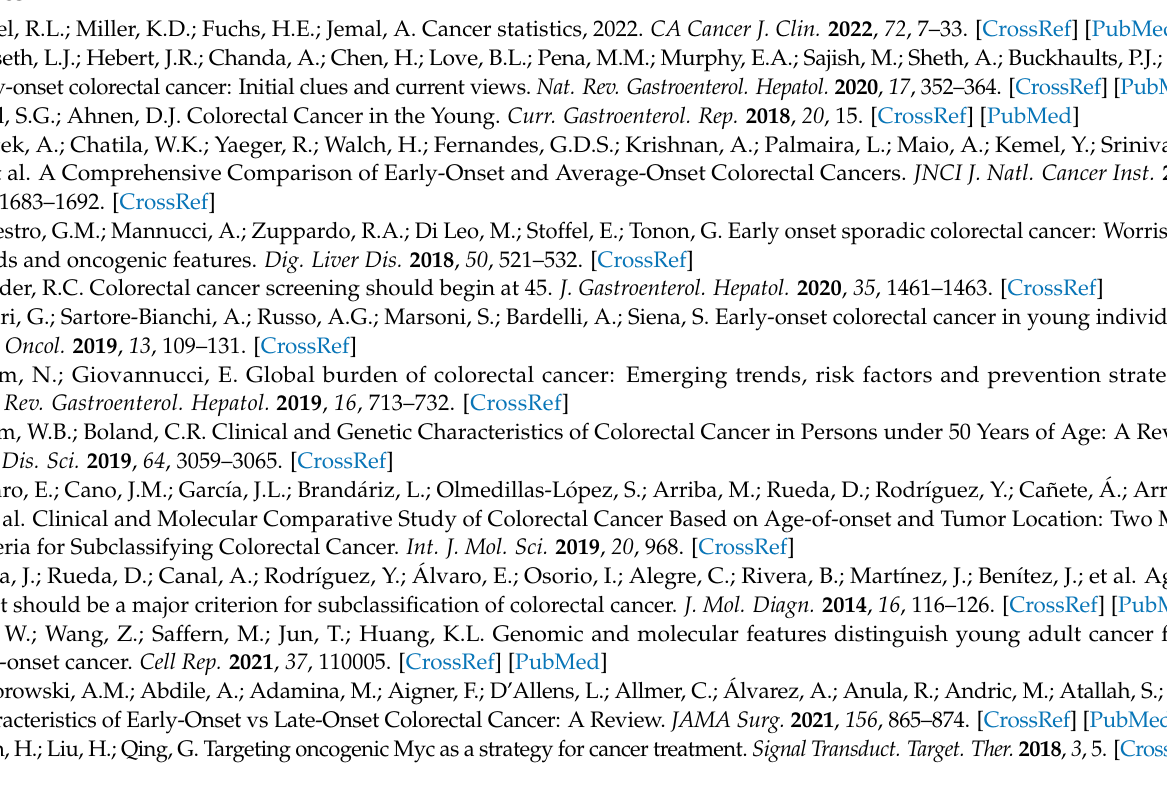
Figure S2: RNA-sequencing quality analysis of the 42 samples in this study; Figure S3: Cell type deconvolution (xCell) predicts a mixture of cell types in our samples; Figure S4: Hallmarks of cancer enriched in EOCRC tumors compared with controls; Figure S5: GSEA Hallmarks in The Cancer Genome Atlas (TCGA) colorectal adenocarcinoma dataset (COAD); Figure S6: Comparisons of high and low MYC tumors; Figure S7: MYC target genes are up-regulated in high- MYC tumors; Table S1: Upregulated gene ontology sets enriched in EOCRC tumors; Table S2: Gene sets enriched in EOCRC tumors; Table S3: Patient demographics associated with MYC copy number